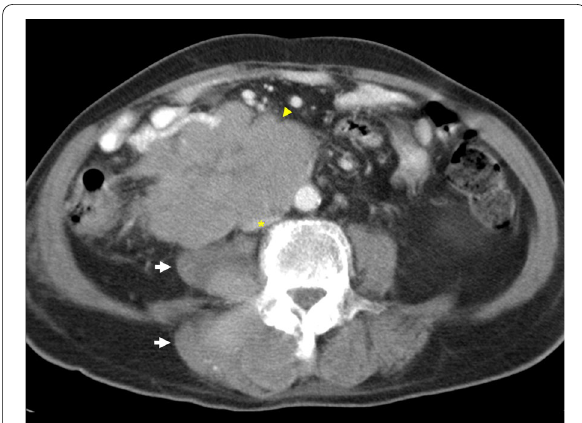
Fig. 12 Extrinsic compression of IVC. Contrast-enhanced axial image demonstrating extrinsic compression of the IVC (asterisk), which is flattened, secondary to a large nodal mass (arrowhead) from lymphoma. Further lymphomatous infiltration of the right psoas and paravertebral muscles is also present (arrows)